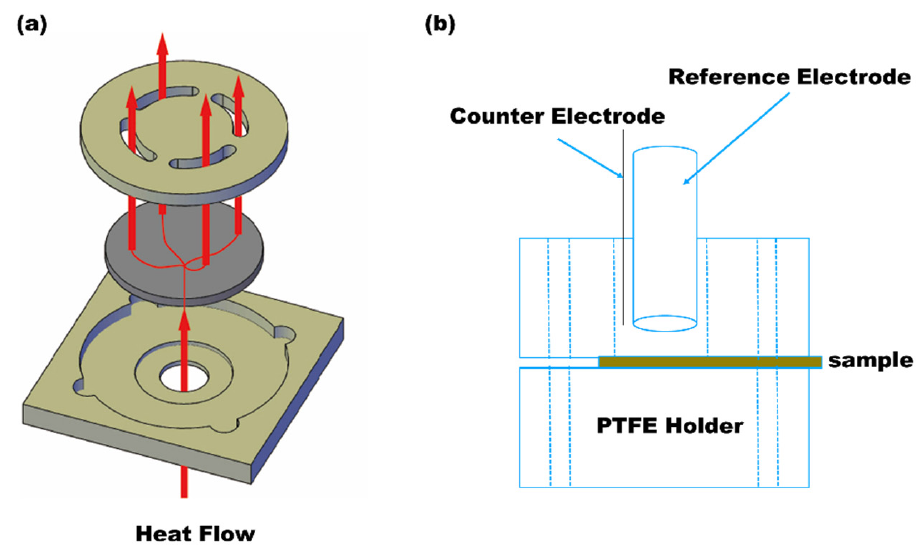
Figure 1. ( a ) In-plane holder for measurement of surface thermal diffusivity and conductivity (from Netsch website) and ( b ) electrochemical test apparatus using in this study (sample as working elec- trode).